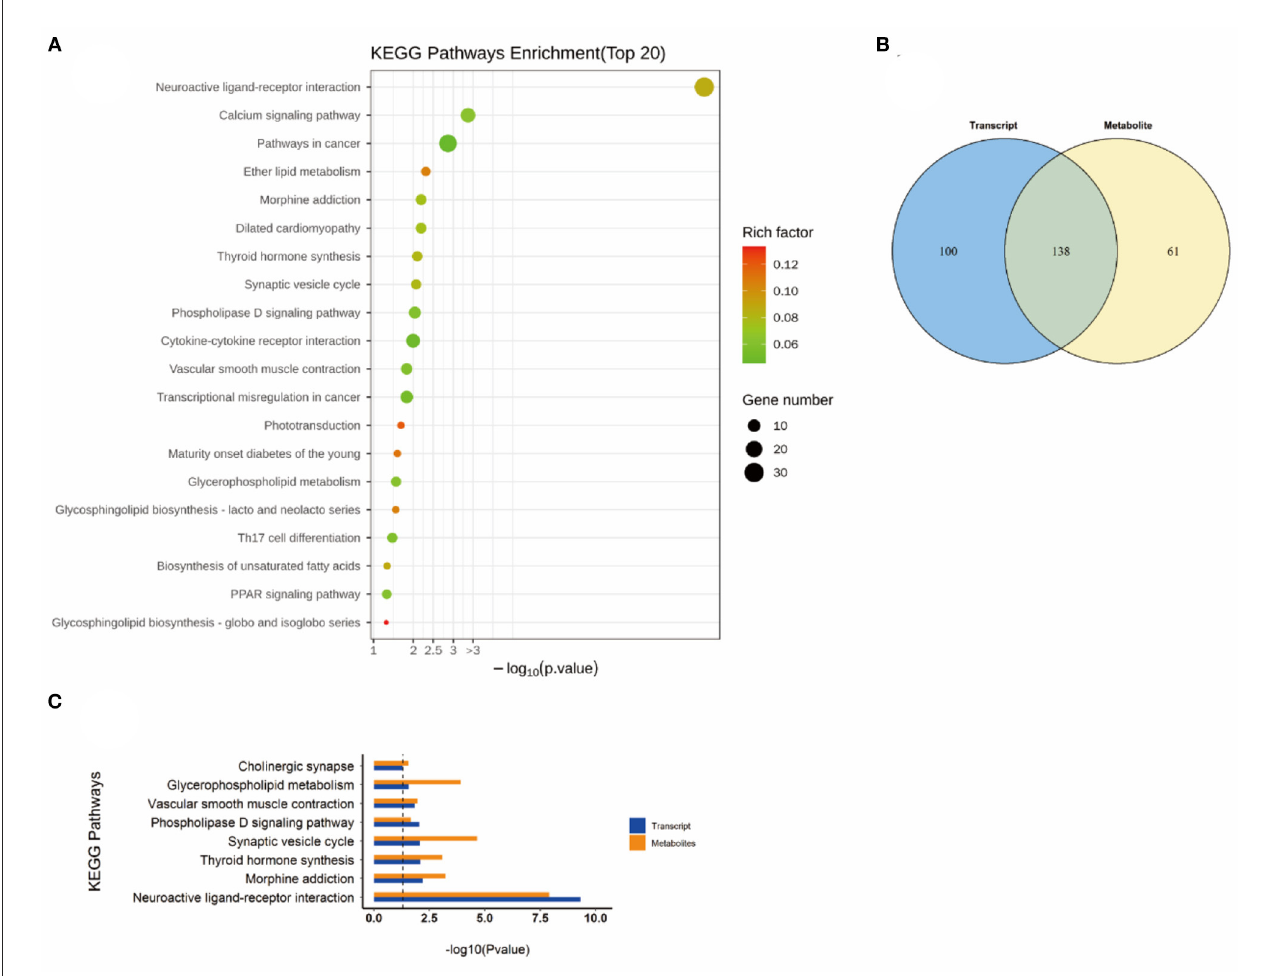
FIGURE8 KEGG pathway analyses of DEGs and DMs identified by comparing the NEMP + H 2 group and the NEMP group. (A) KEGG pathway analyses of DEGs. (B) Venn diagram of the KEGG pathway involving DEGs and DMs. (C) Enrichment analysis of KEGG pathway between DEGs and DMs. N =